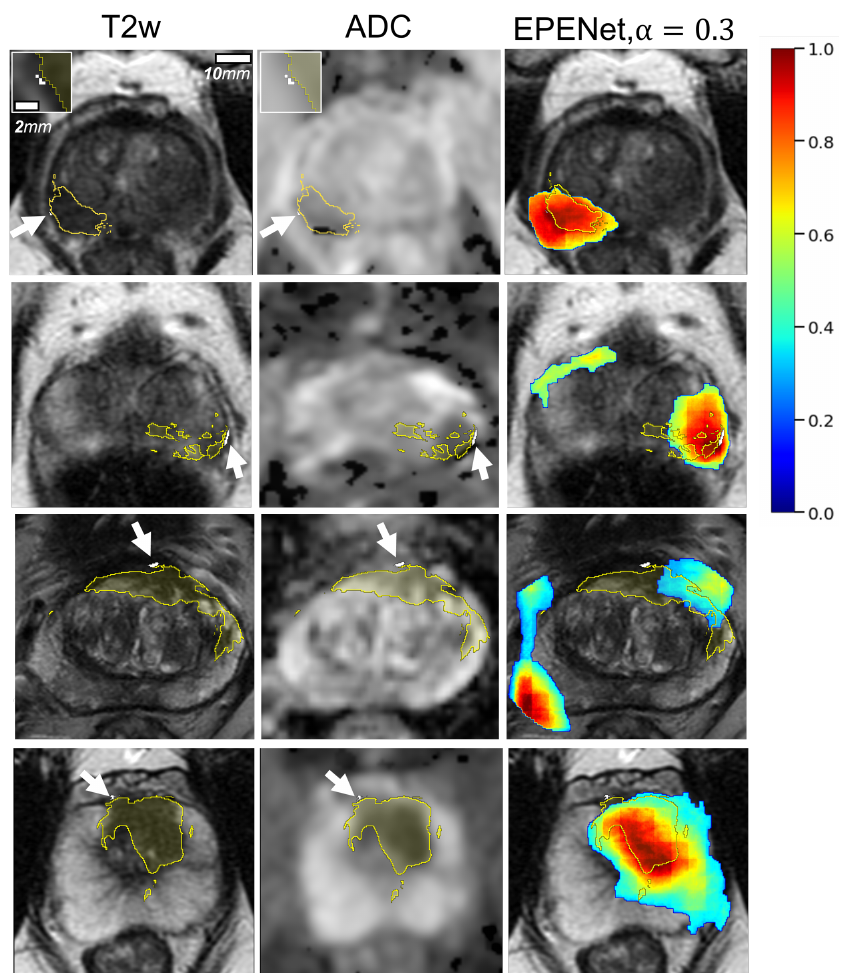
Figure A1. Visualization of predictions for extraprostatic extension in four example cases from the test set; each row shows the leading slice from a different case. Column (1) input T2w images; Column (2) input ADC images; yellow labels outline cancer within the prostate, white labels outline extraprostatic extension (EPE); white arrows point to the small EPE regions; the panels in the corners show zoomed- in 5 mm × 5 mm areas containing EPE. Column (3) EPENet predictions. Predictions are probability maps displayed in a cold to hot color scheme (dark blue–0, dark red–1). Note that EPENet predictions highlight lesions with extraprostatic extension. EPENet does not show any predictions for cancer lesions fully contained within the prostate